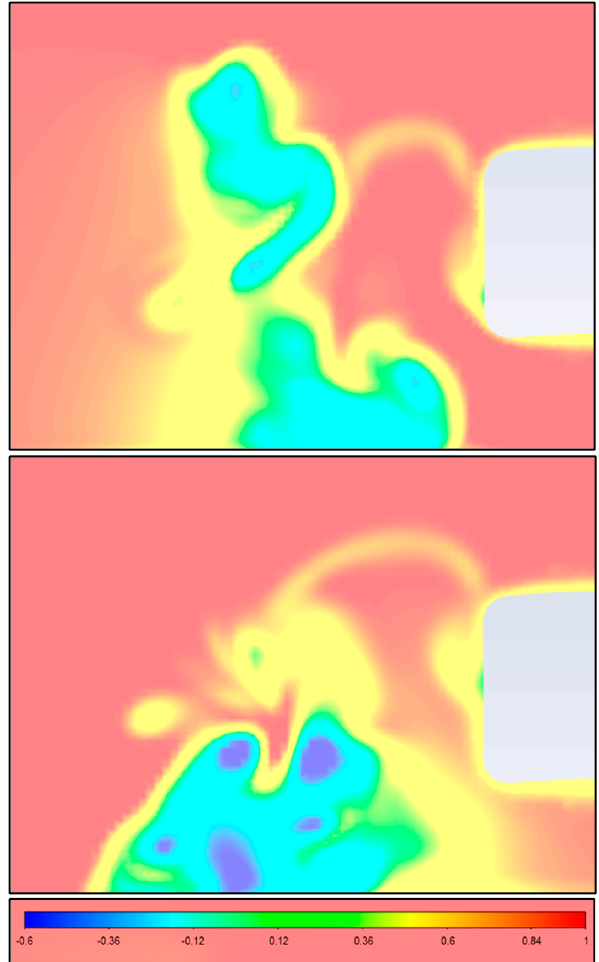
Figure 10. Total pressure coefficient at plane (cid:1878) = −2.1 (underbody intake) (AOA of 30°, 32°, and 34°).